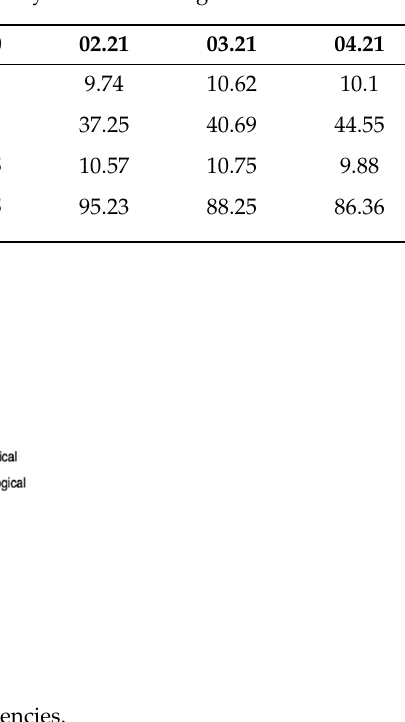
Table A2. Mean language utterance and fluency assessed during each tDCS follow-up.